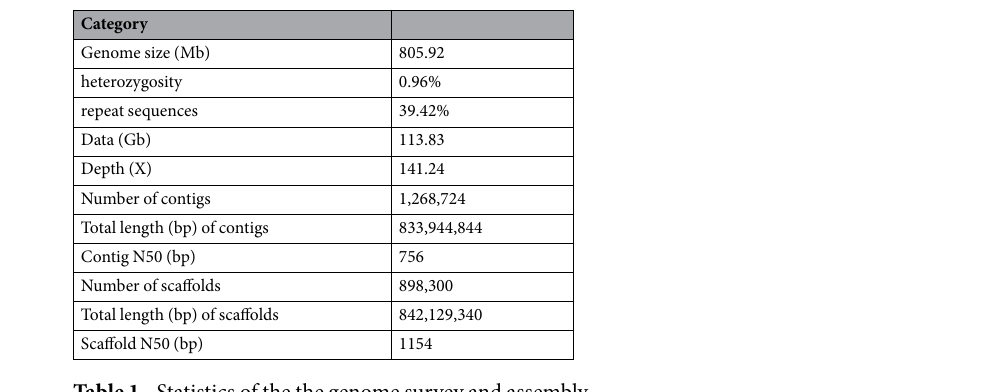
Table 1. Statistics of the the genome survey and